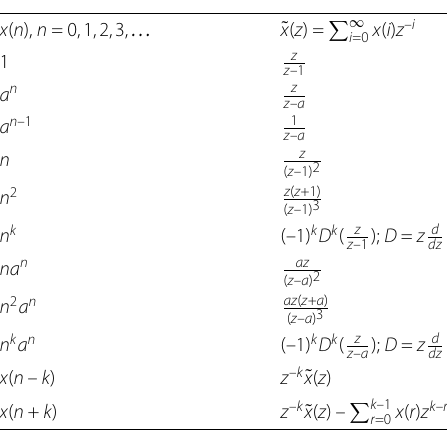
Table 1 Z-transform